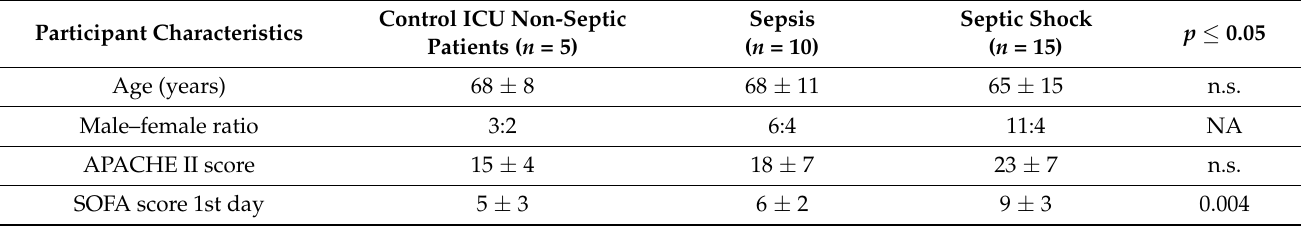
Table 1. Clinical data in each subgroup: demographics, severity scores, analytical data and docu- mented microbiologic etiology of the infectious process from the control intensive care unit, sepsis and septic shock